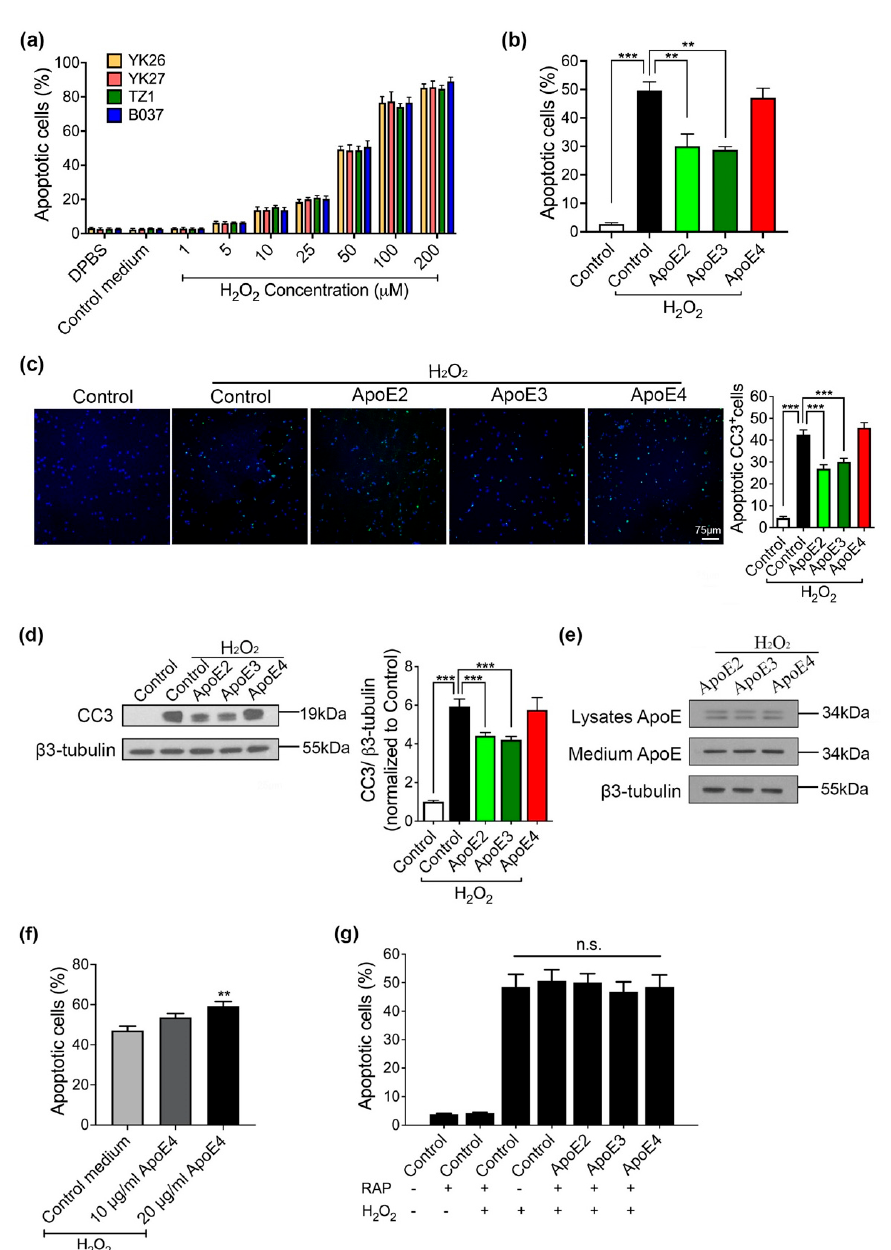
Figure 3. ApoE2 and ApoE3 prevent neurons from H 2 O 2 -induced apoptosis through ApoE receptor. ( a ) 6 h treatment of H 2 O 2 caused neuronal apoptosis in a dose-dependent manner. ( b ) Apoptosis assay for neurons treated with control medium or neurons co-treated with ApoE isoforms and H 2 O 2 . The percentage of apoptosis was evaluated by HT TiterTACS Apoptosis Detection Kit. ( c ) Confocal images showing cleaved caspase 3 (CC3) positive cells under different conditions and quantification was performed. At least five random fields were counted per coverslip. White scale bar, 75 μ m. ( d ) Western blot analysis comparing CC3 level between control medium and ApoE isoforms treated neurons in the absence or presence of H 2 O 2 . ( e ) Western analysis of both intracellular and extracellular ApoE levels after H 2 O 2 treatment. ( f ) Apoptosis level was measured with neurons co-treated with ApoE4 (10 and 20 μ g/mL) and H 2 O 2 . ( g ) Day 60 neurons were pretreated with 200 nM RAP for 2 h before adding ApoE-containing or control medium. Apoptosis assay was performed. n = 4 per line, data are presented as a summary of all lines (mean ± SEM) using one-way ANOVA and Dunnett test. ** p < 0.01, *** p < 0.001 versus neurons co-treated with control medium and H 2 O 2 . n.s.: non-significant